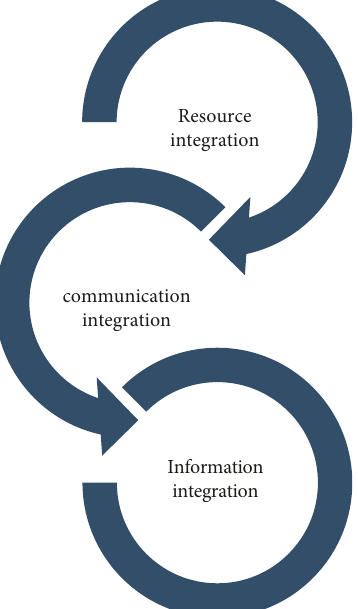
Figure 2: Supply chain value